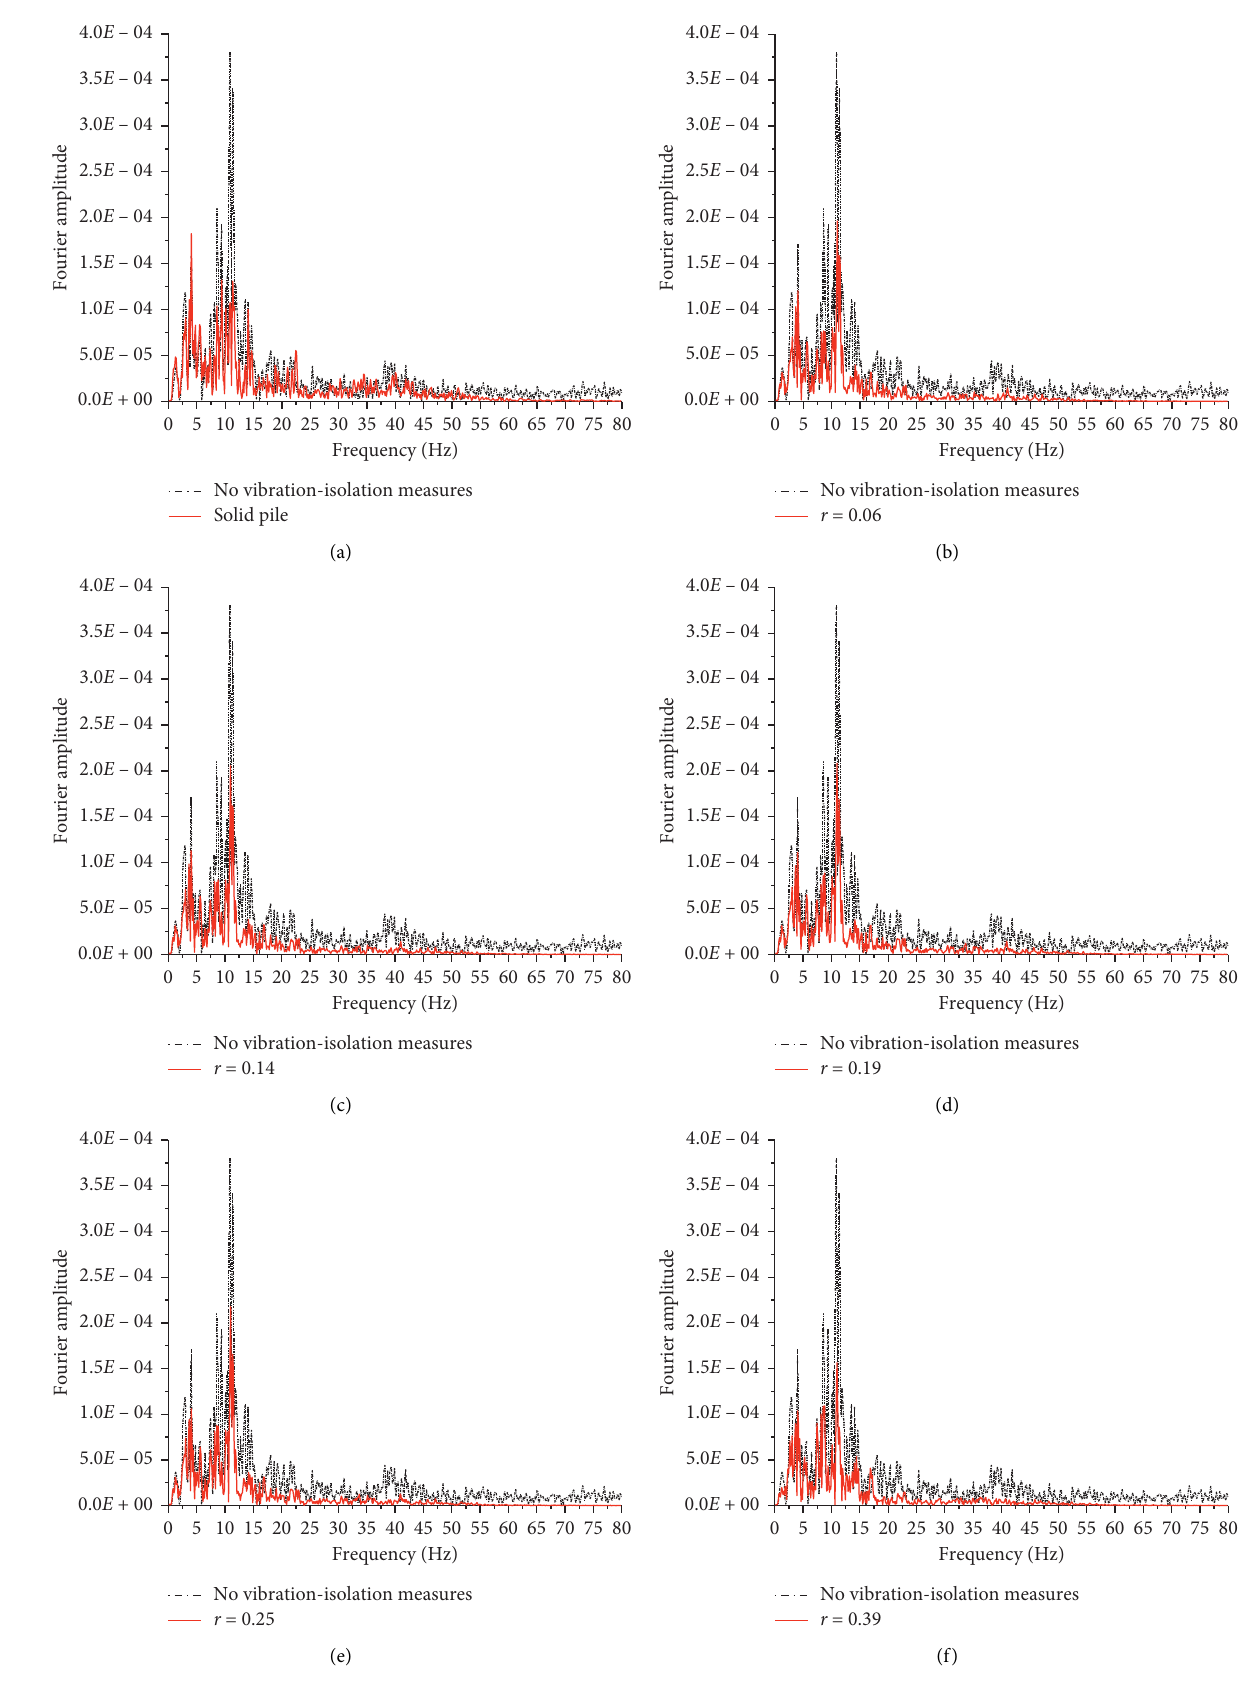
Figure 30: Influence of hollow ratio ( r ) on vibration-isolation effect (comparison of frequency